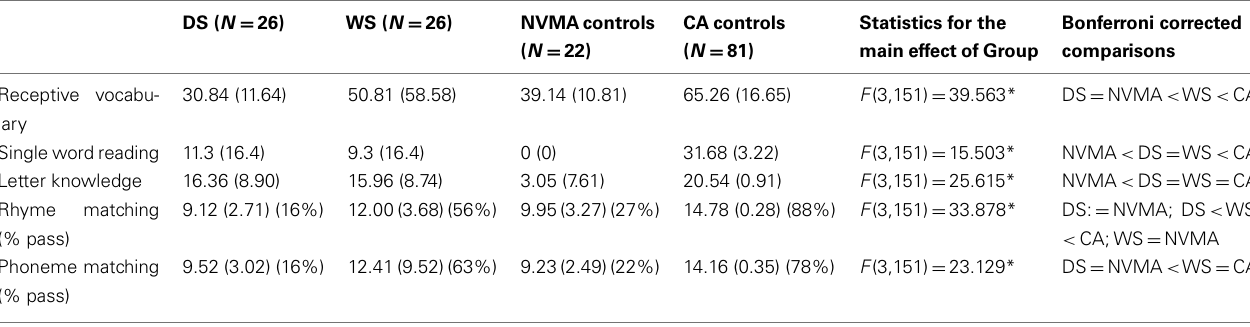
Table 3 | Language and literacy profiles.